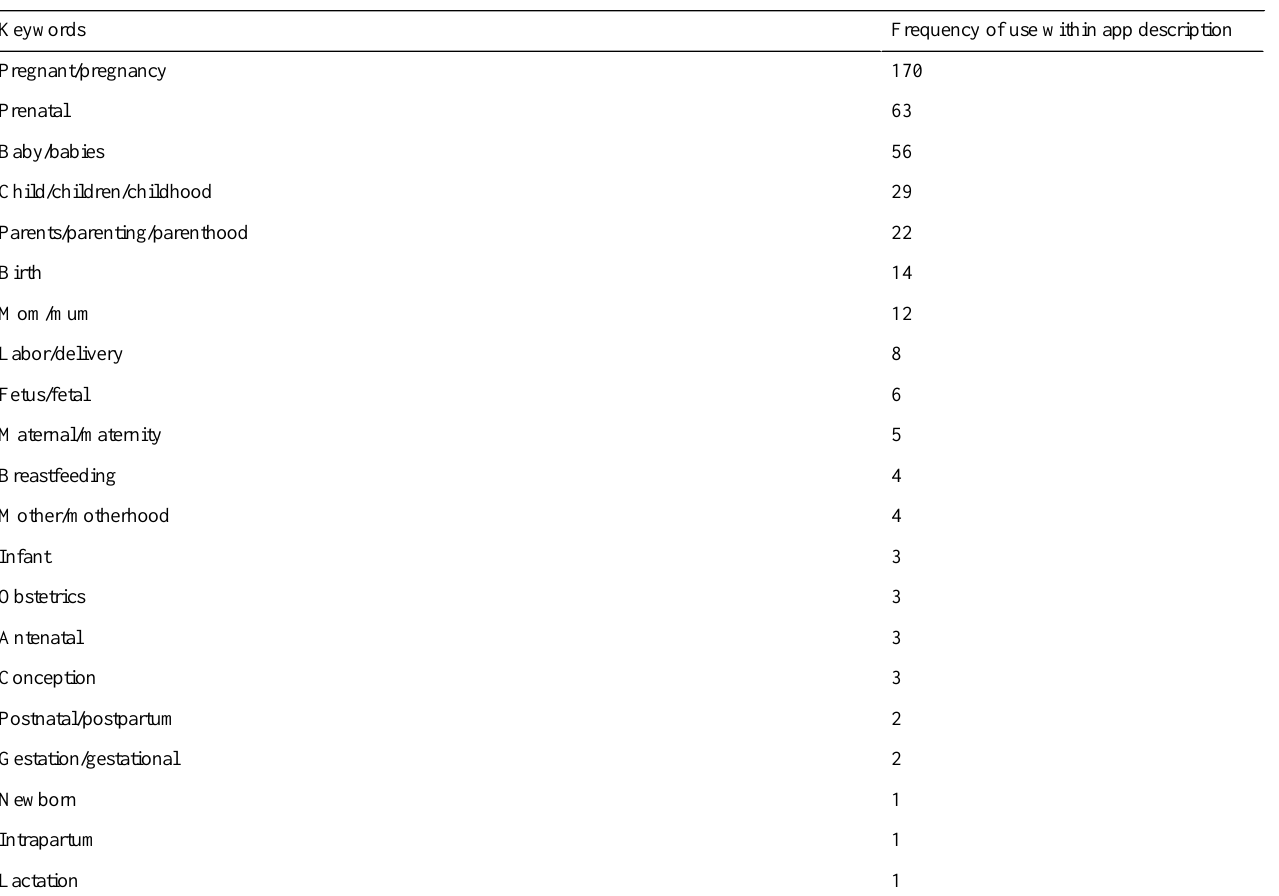
Table 1. List of keywords (N=34).